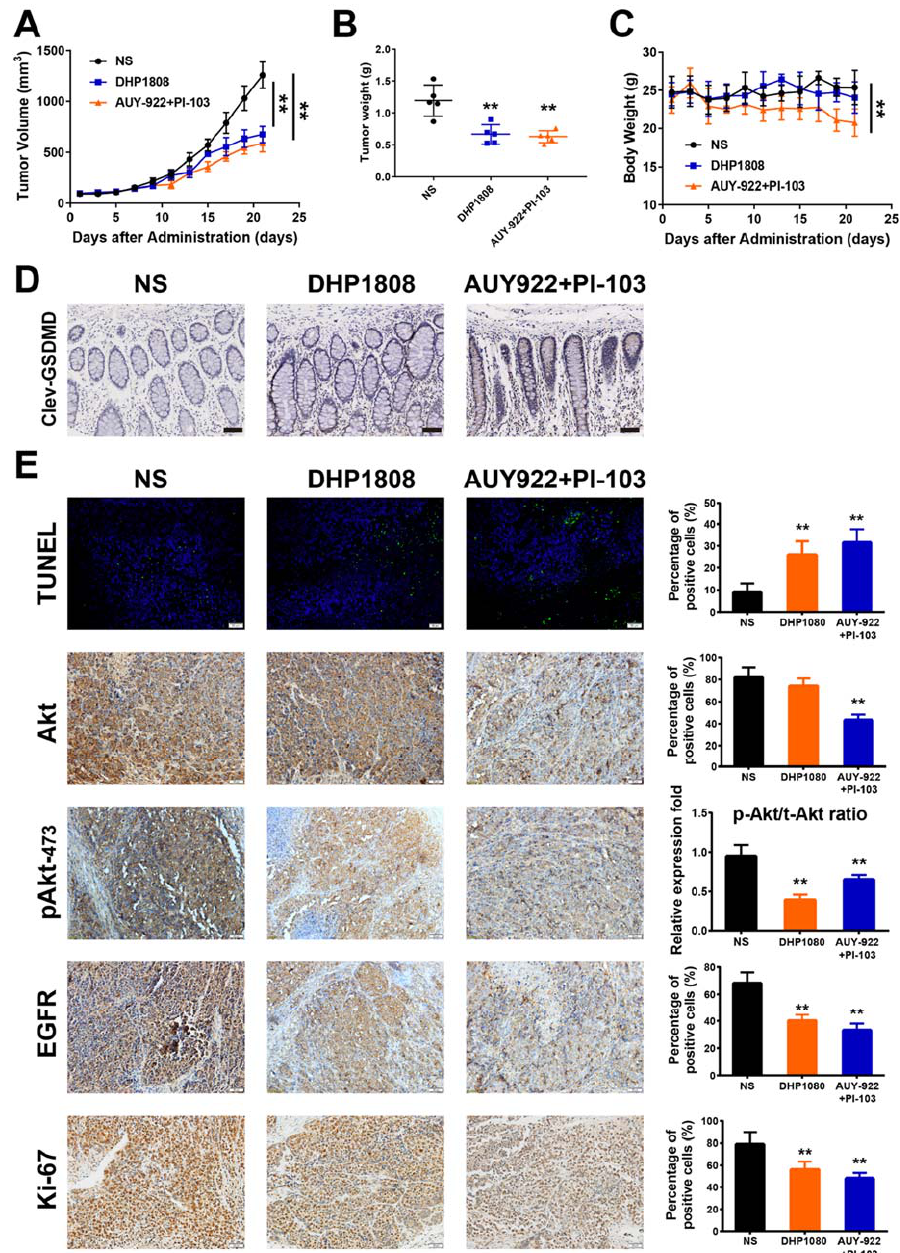
Figure 7. Inhibition e ff ects of DHP1808 in a xenograft model. ( A ) Mice bearing A375 melanoma xenograft were treated with NS control, 30 mg / Kg DHP1808, and 30 mg / Kg AUY-922 plus 10 mg / Kg PI-103 once a day. Tumor volume data were presented as mean ± SD. ( B ) Tumor weight change of mice in di ff erent group. ( C ) Changes on mice bodyweight in each group. ( D ) IHC analysis of cleaved GSDMD in intestine tissues, scale bar: 100 µ m. ( E ) TUNEL staining and IHC analysis of Akt, pAkt473, EGFR and Ki-67. Representative images of positive staining are shown, scale bar: 50 µ m. ** p < 0.01 compared to control group. The intraperitoneal administration of 30 mg / Kg DHP1808, and 30 mg / Kg AUY-922 plus 10 mg / Kg PI-103 were